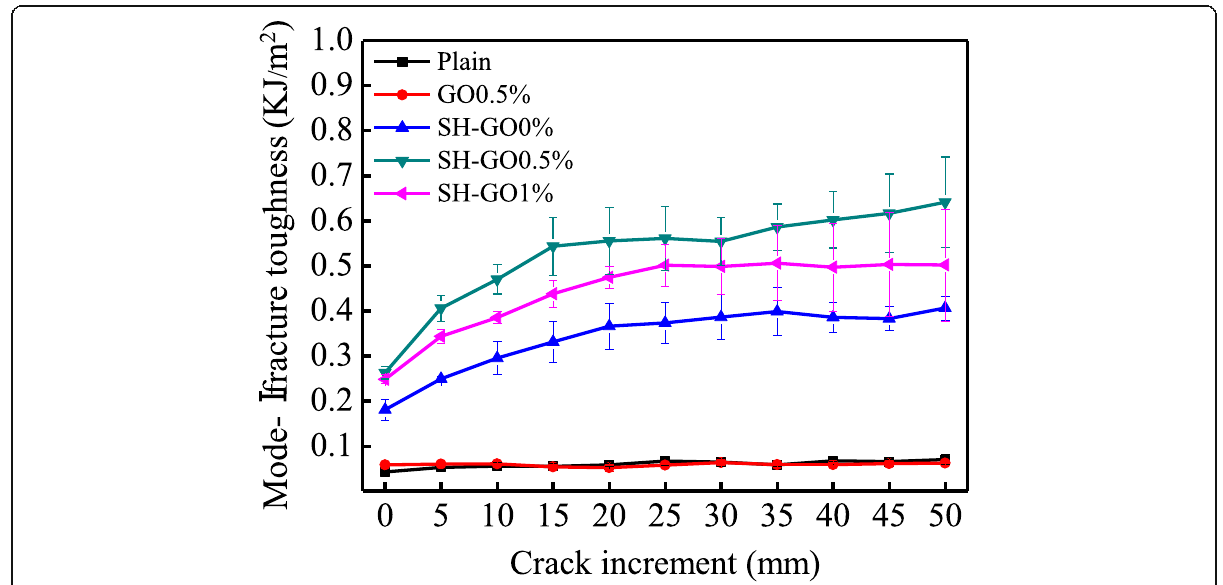
Fig. 10 Comparison of the R -curves for various specimens during DCB tests